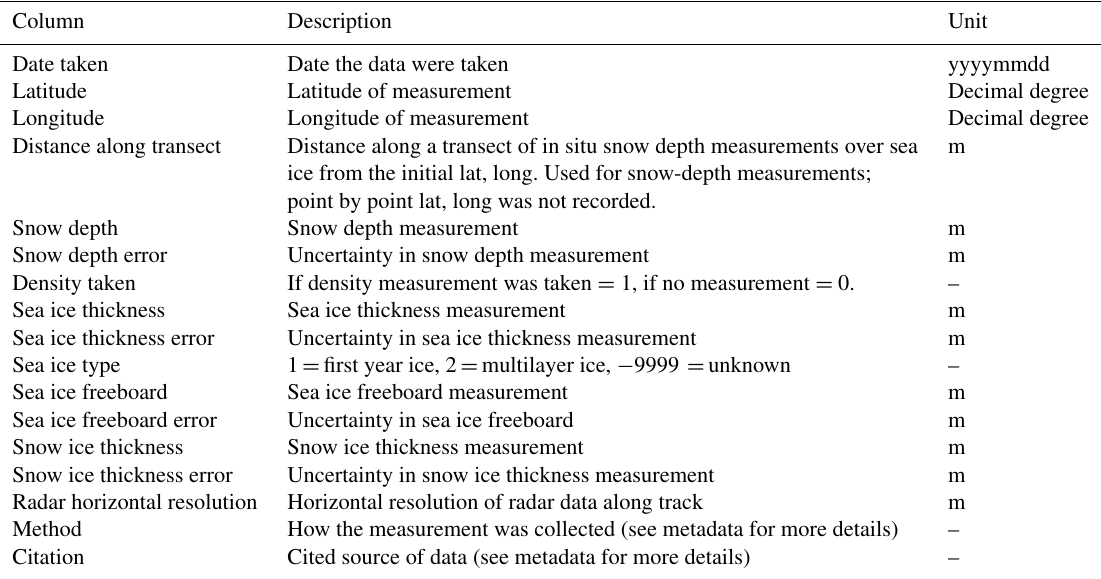
Table 3. The parameters for each snow depth on sea ice measurement in the SUMup dataset with a brief description and the unit of measurement.